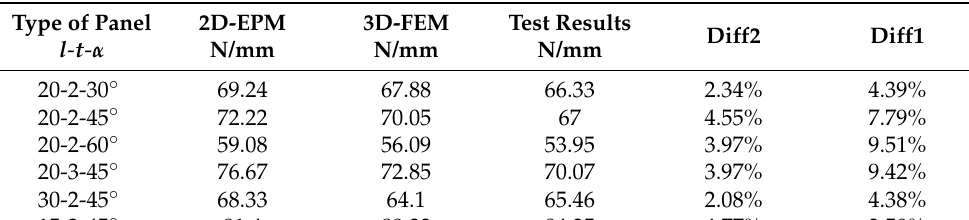
Table 2. Comparison of the slopes of displacement–load curves from the experiments, 2D-EPM, and 3D-FEM with different structural parameters under three-point bending.